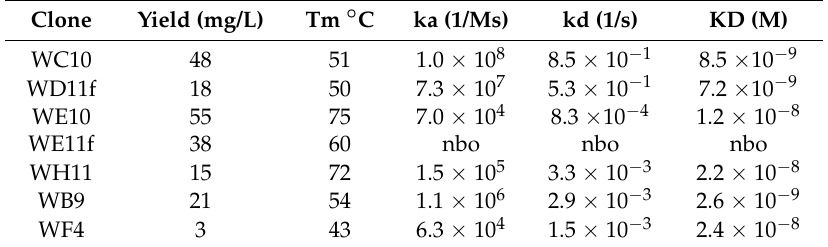
Table 1. Anti-WEEV sdAb yields, melting points, and binding